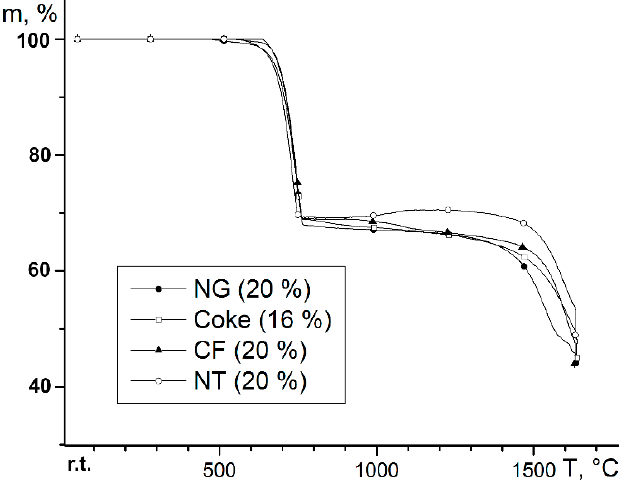
Figure 4. Weight loss in calcium carbide synthesis from commercial carbon sources: nanoglobules, coke, carbon fiber, and nanotubes according to TGA (m, %).